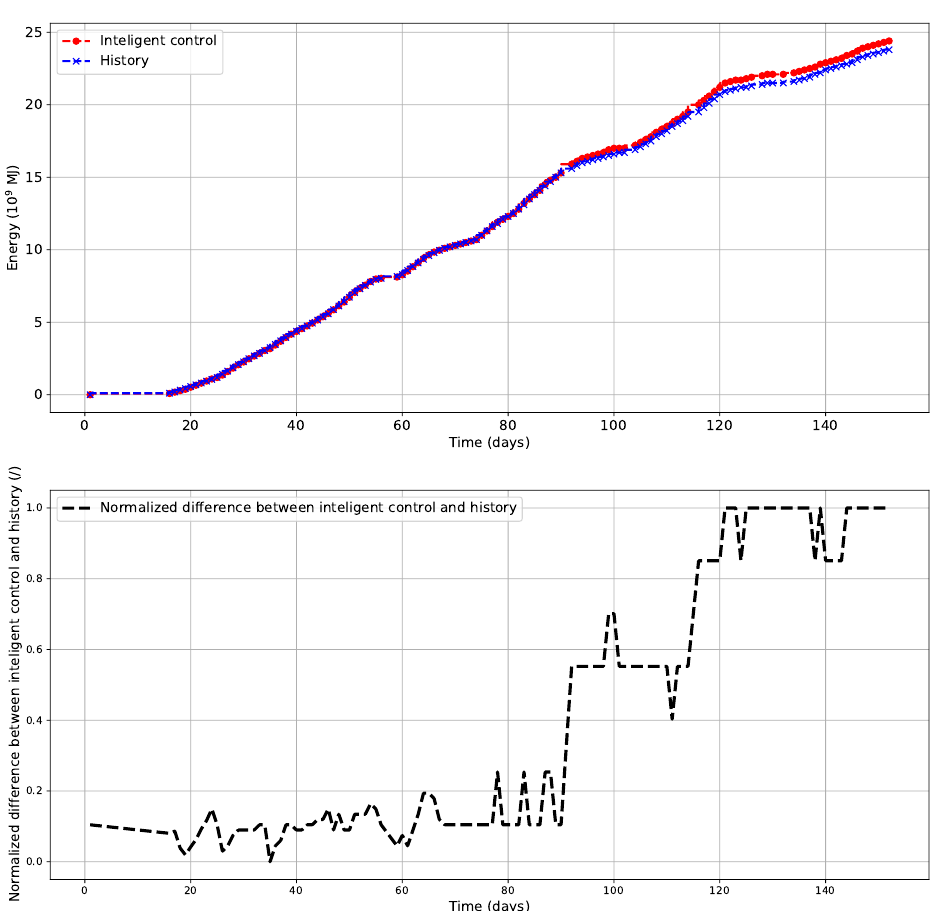
Figure 7. Influence of the developed control on the energy obtained during the gas withdrawal